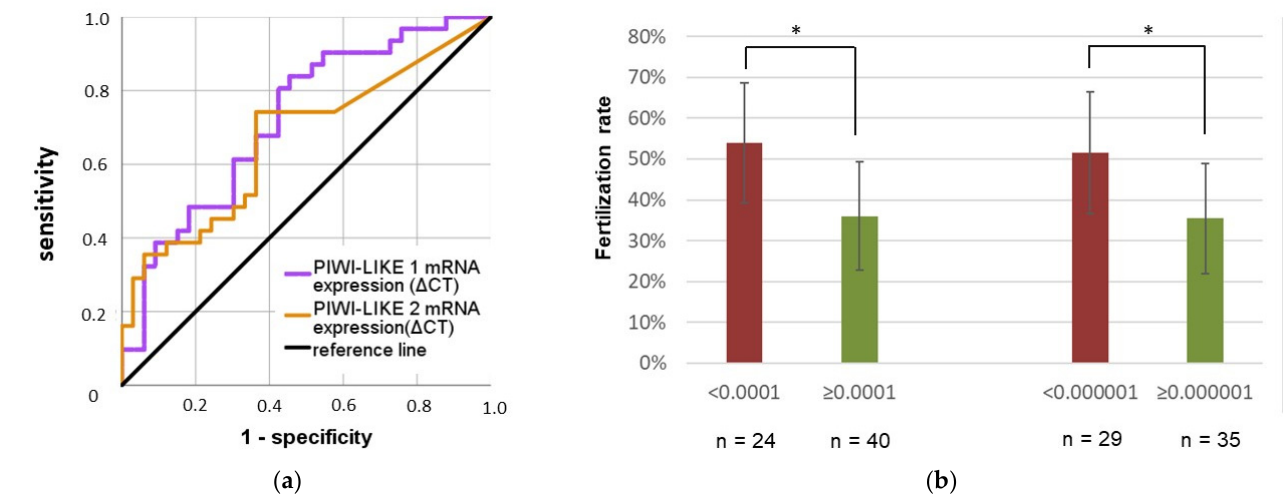
Figure 3. Potential of PIWI-LIKE 1 and 2 spermatozoal mRNA level to distinguish between high and low-fertilization patient groups applying ( a ) ROC analyses and ( b ) different cut-off rates for PIWI-LIKE 1 and 2. * p < 0.05.